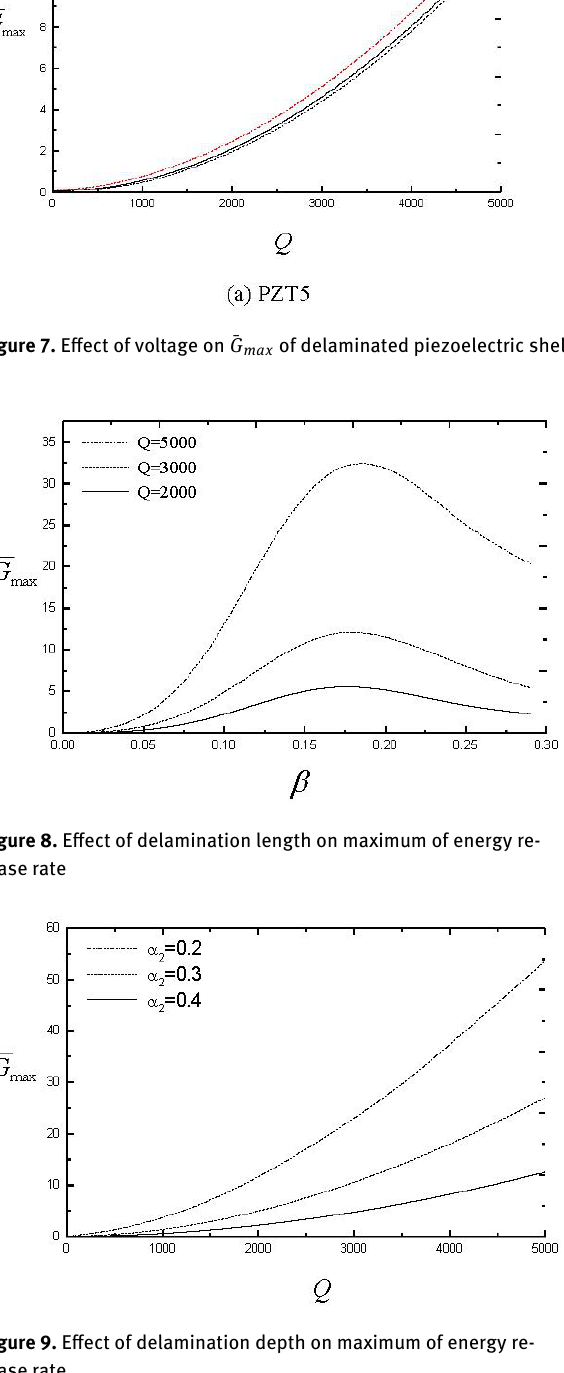
ture and moisture rise ∆T = ∆C = 0. From the figure, it is observed that applying negative voltage on shell decreases the maximum of energy release rates. This is due to the